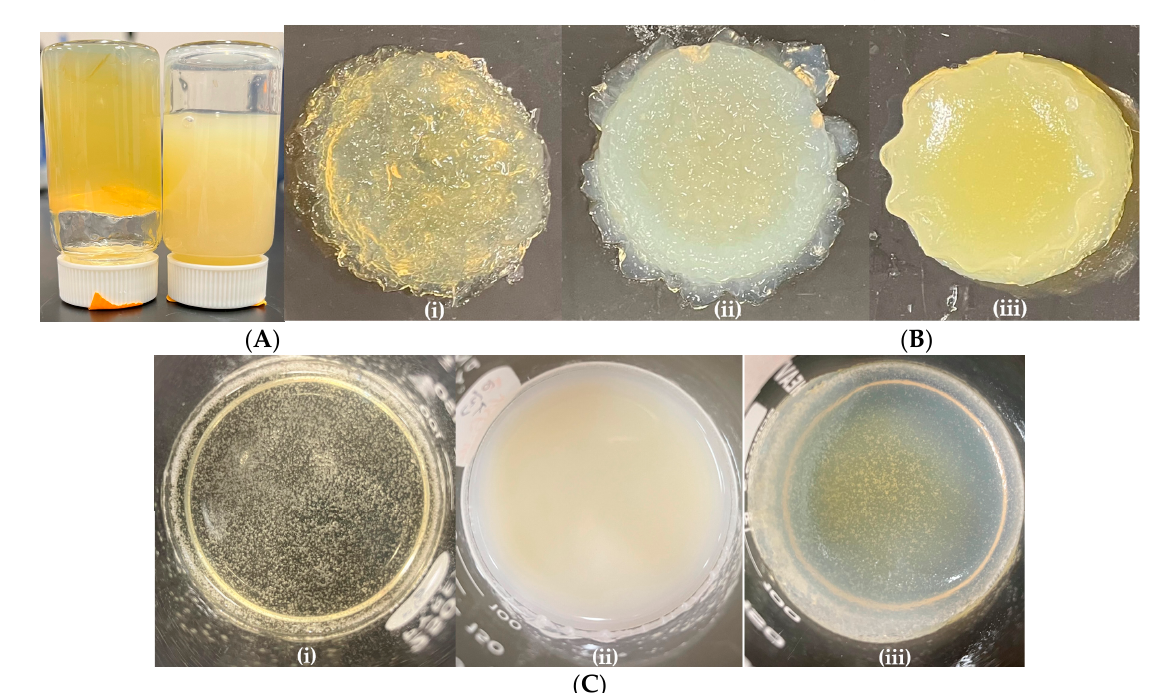
Figure 1. ( A ) Turbidity and viscosity of hydrogel solution at varying final CS concentrations